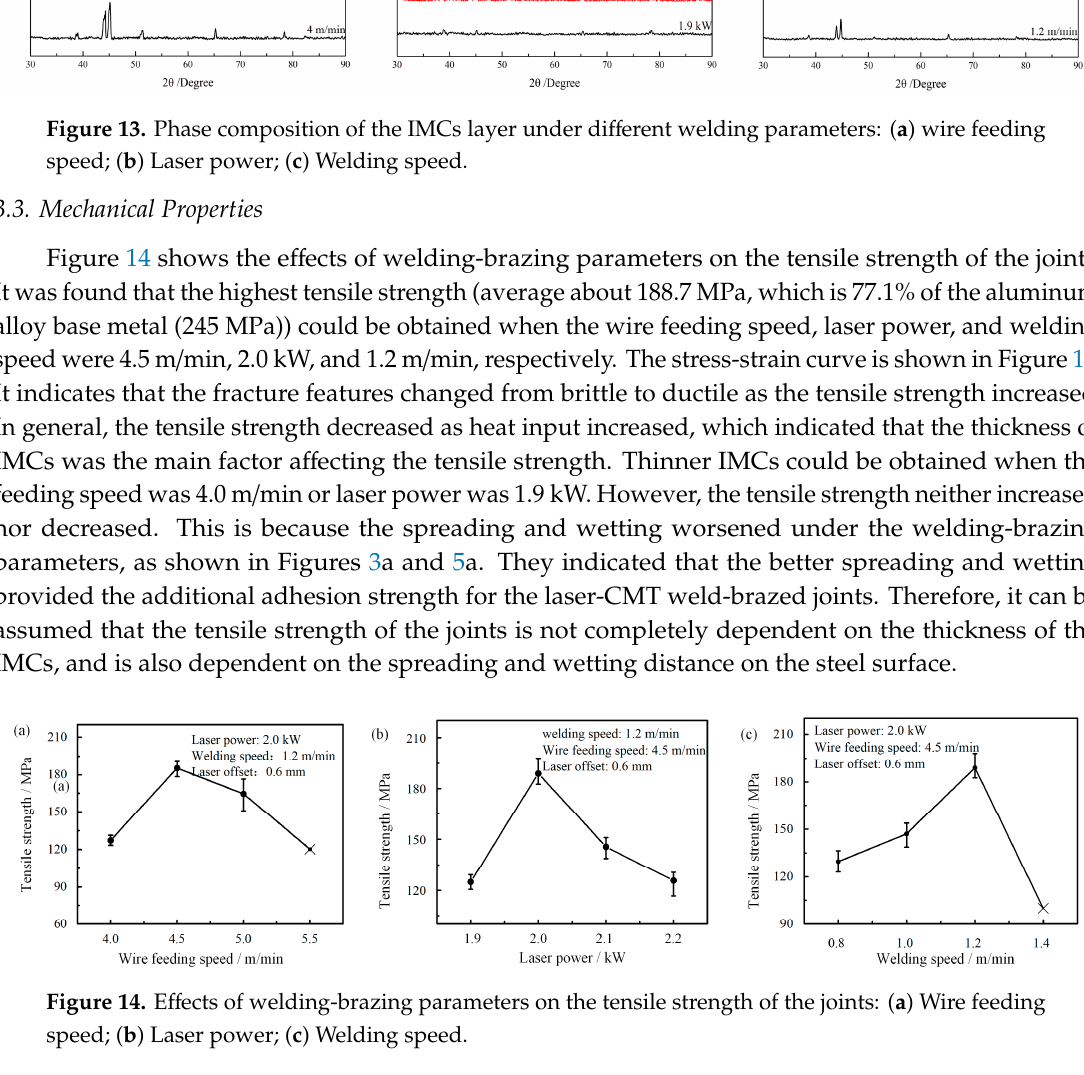
Figure 13. Phase composition of the IMCs layer under different welding parameters: ( a ) wire feeding speed; ( b ) Laser power; ( c ) Welding speed.